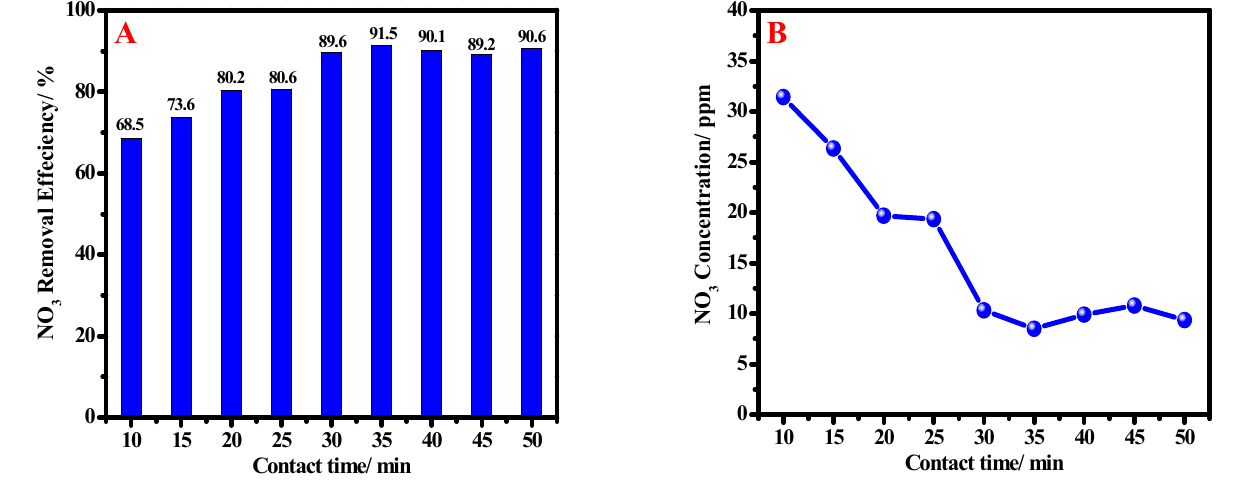
Figure 7. The removal efficiency of nZVI (1.0 g/L) with various contact times ( A ) and dependence of nitrate concentration after treatment on contact time ( B ) at ambient temperature.